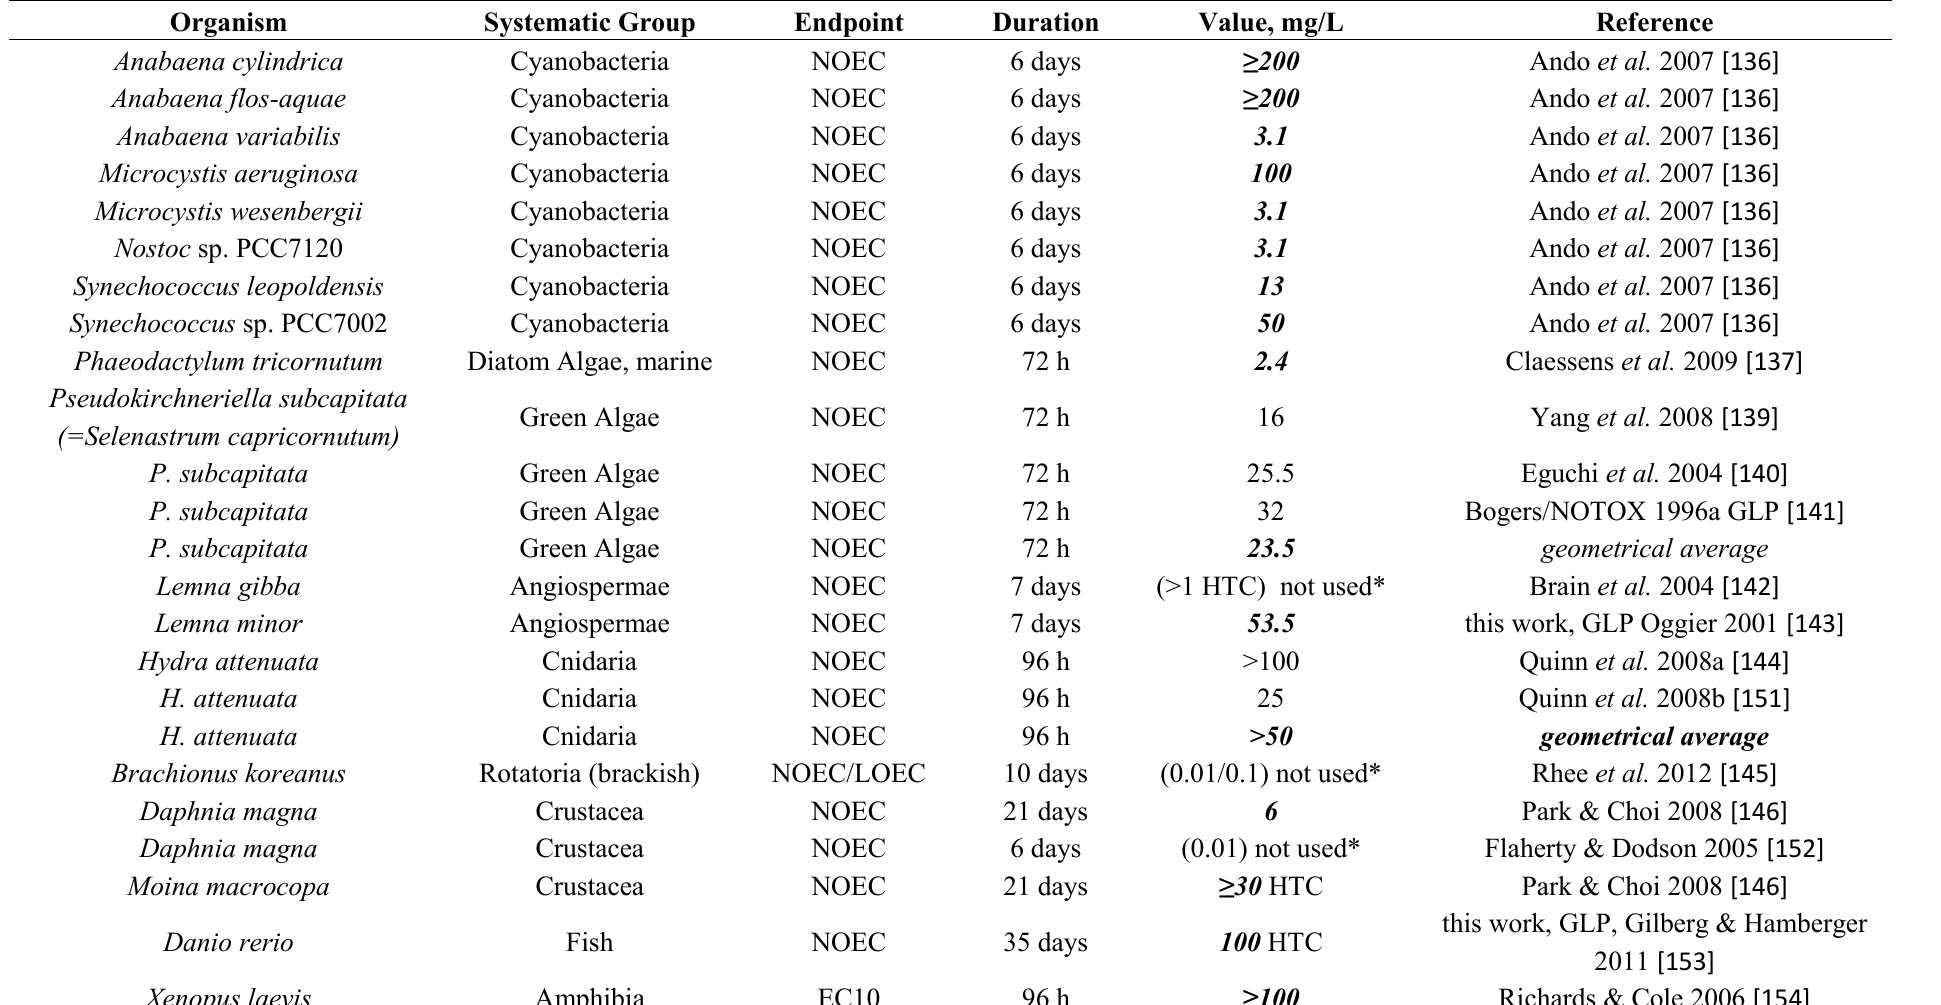
Table A8. Chronic Ecotoxicity Data for